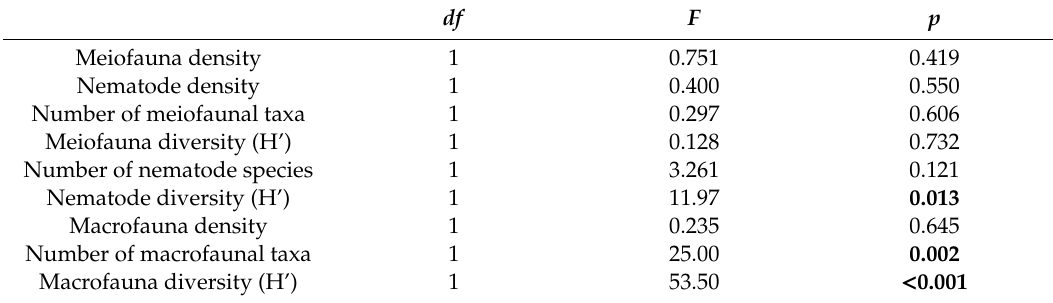
Table 3. Differences in univariate indices from macro- and meiofauna between habitat/environment (H2) using one-way ANOVA. Analysis of macro- and meiofauna densities were done on log (x + 1) data.